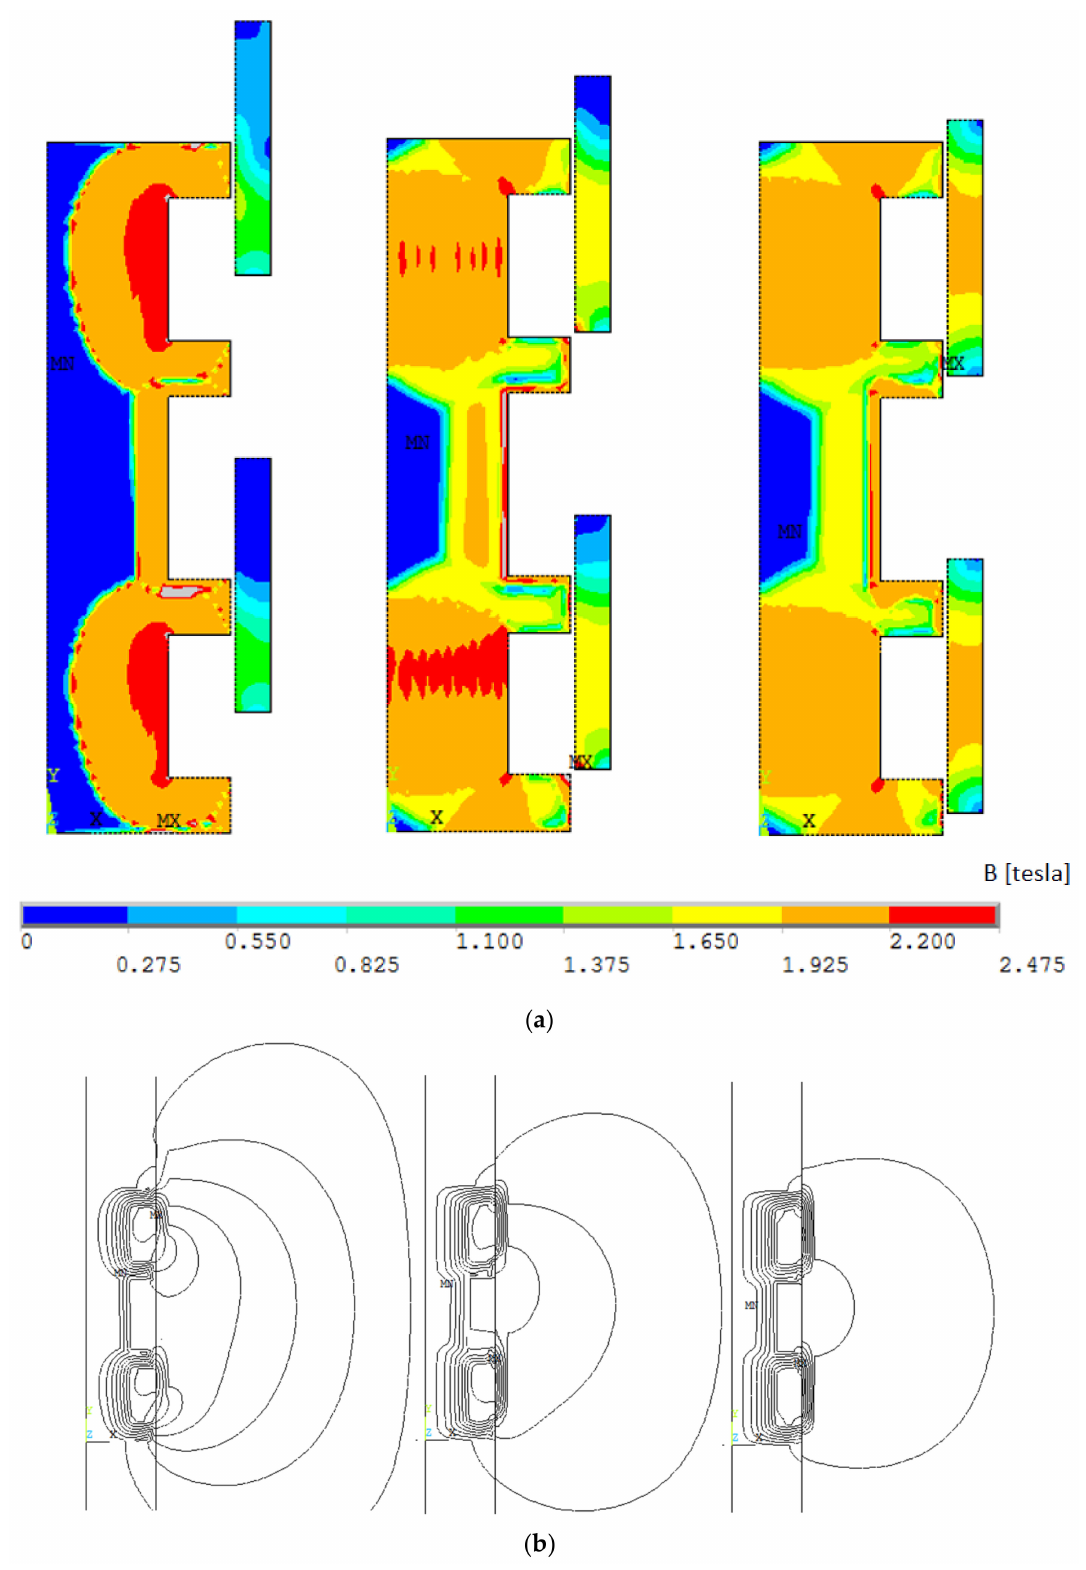
Figure 21. Magnetic field ( a ) and magnetic field lines ( b ) for hammer displacement (from the left): 1 mm, 2.5 mm and 4 mm—Variant